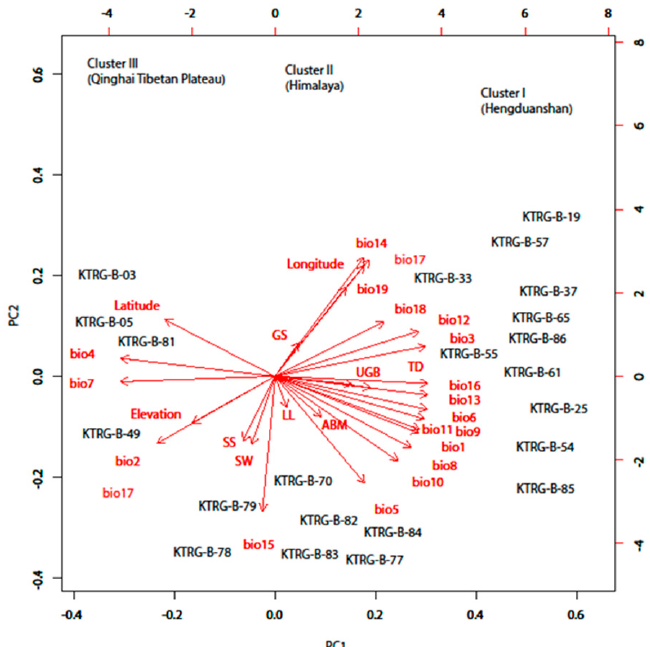
Figure 6. Principal component analysis (PCA) of environmental variables, GS, morphological and reproductive traits among the 22 turnip landraces under investigation. Principal components PC1 and PC2 explain 60.62% and 14.33% of variance, respectively. The landraces are represented by their accession numbers according to Supplementary Table S1. This figure shows the difference in landrace usage from three environments.